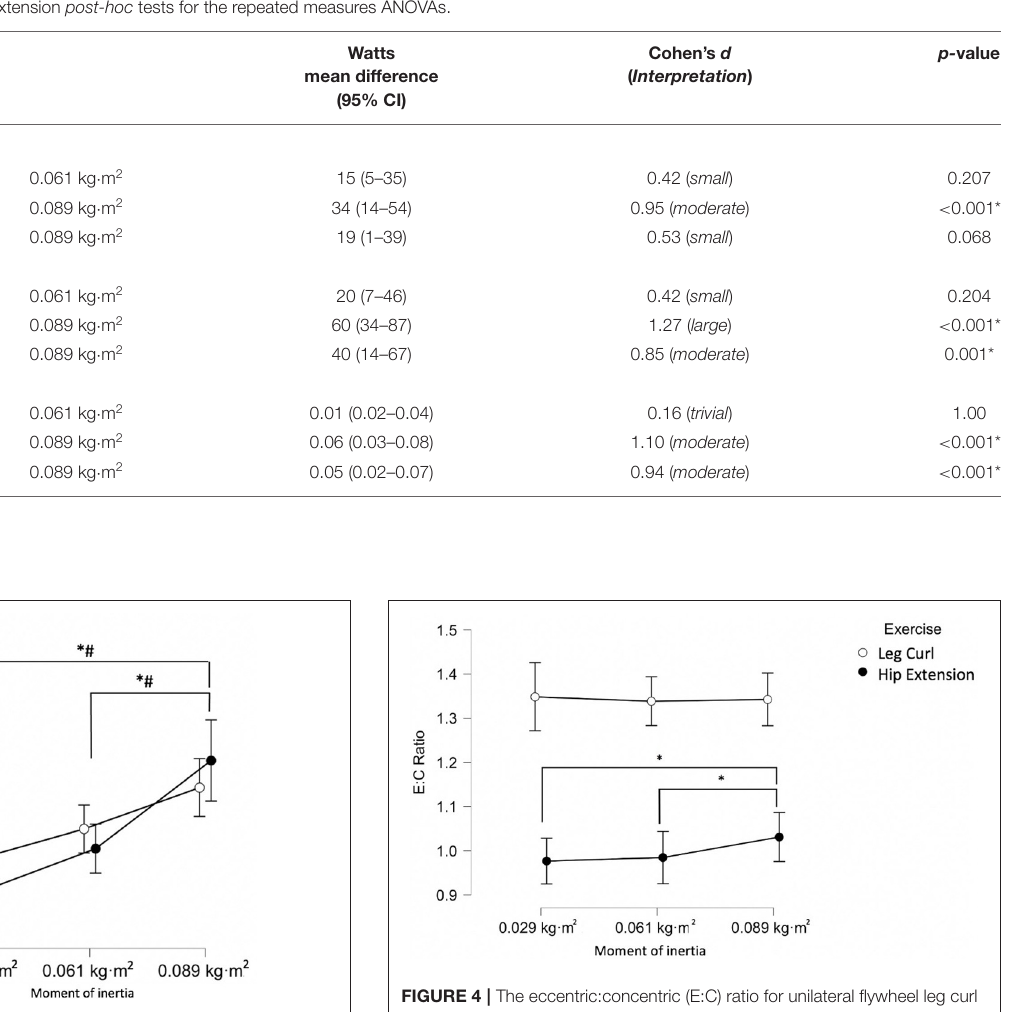
TABLE 1 | Flywheel unilateral hip extension post-hoc tests for the repeated measures ANOVAs. Moment of inertia Watts